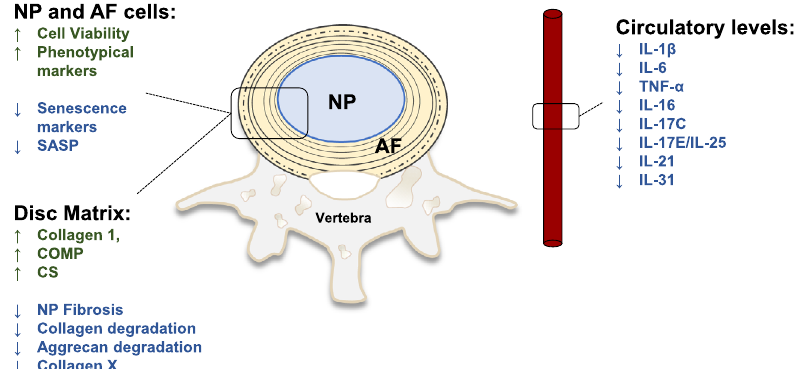
Fig. 9 Senolytics ameliorate age-related disc degeneration. a Schematic summarizing the overall bene fi cial effects of D + Q contributing to alleviation of intervertebral disc degeneration during